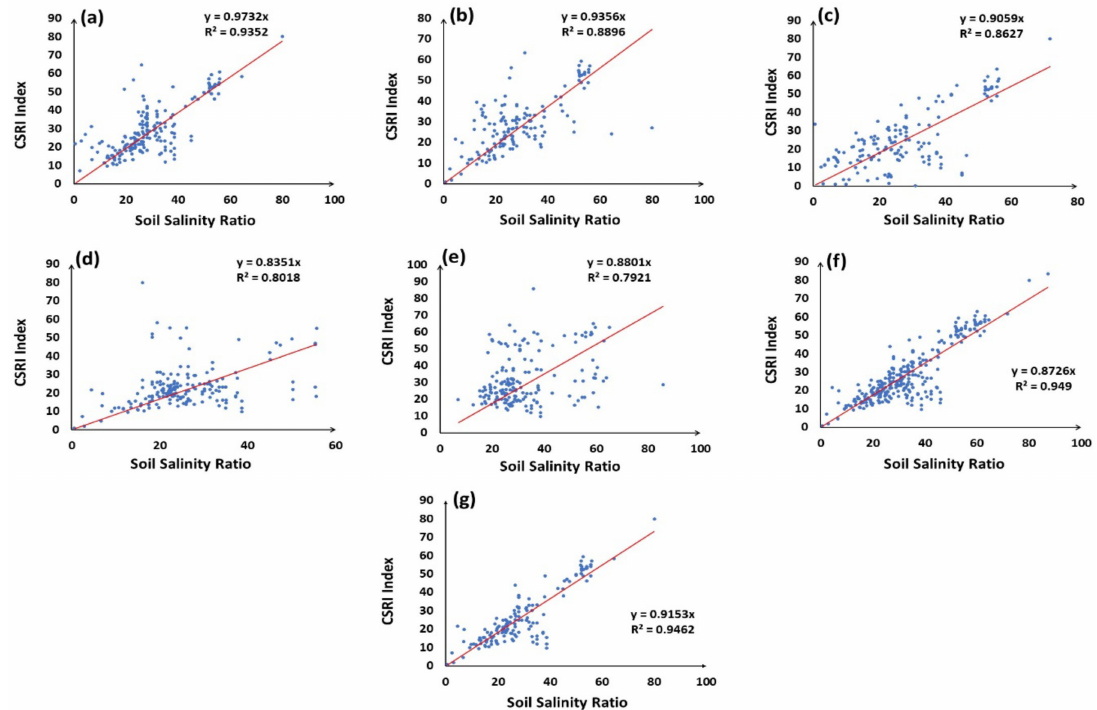
Figure 9. Validation results of CSRI index (see Figure 8) based on the ground control sample points obtained during field work and based on the historical soil salinity dataset (see Table 4). The charts indicate that valid soil salinity maps have been developed for: ( a ) 1990, ( b ) 1995, ( c ) 2000, ( d ) 2005, ( e ) 2010, ( f ) 2015, and ( g )